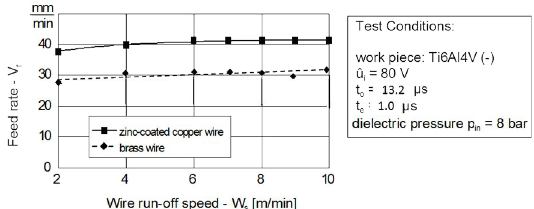
on the wire feed s